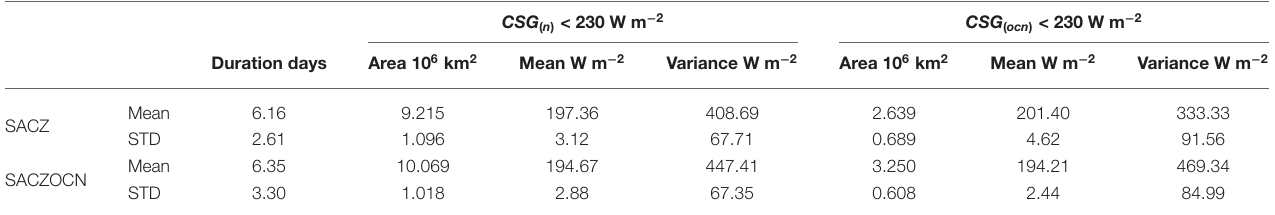
Lines one and two refer to the average value for all SACZ episodes and the third and fourth lines refer to the average value for oceanic SACZ episodes.